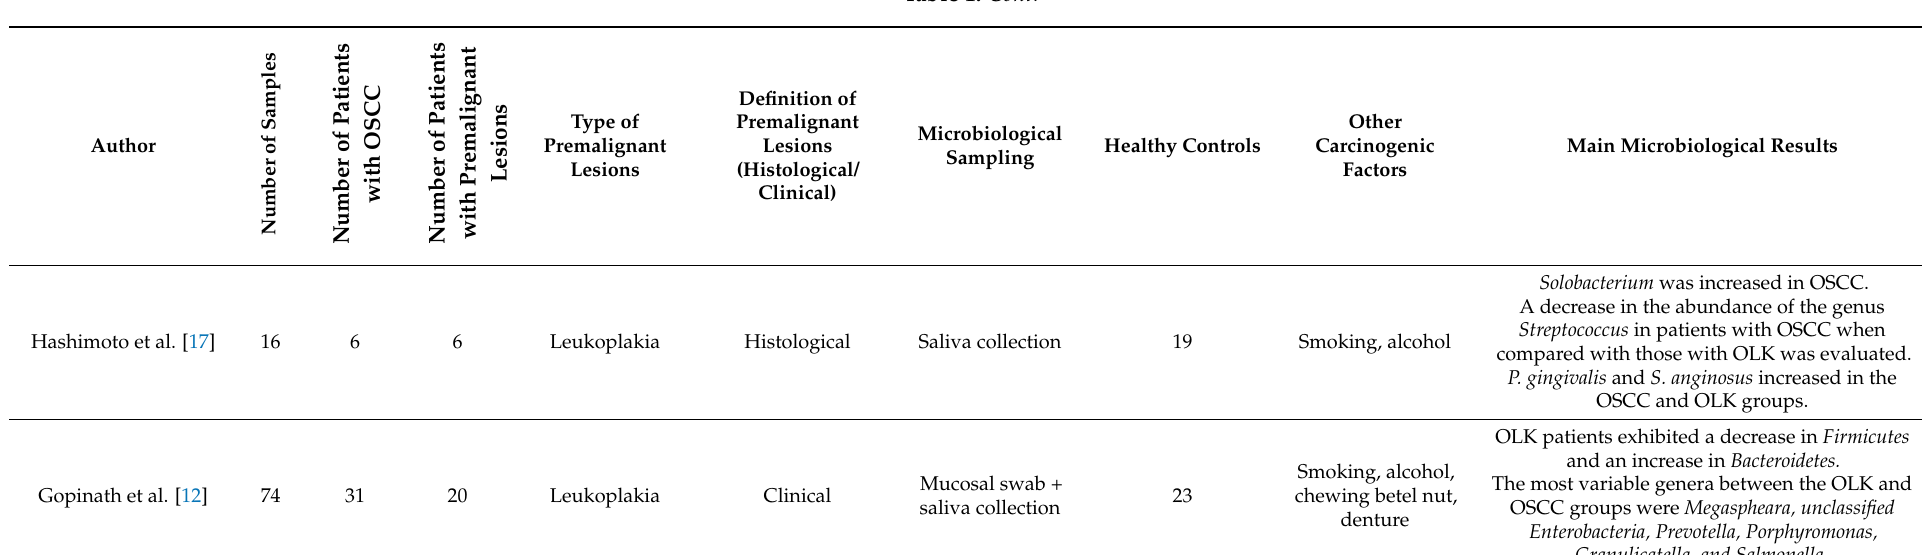
Table 1. Original studies available on oral leukoplakia and the microbiome up to May 2021.